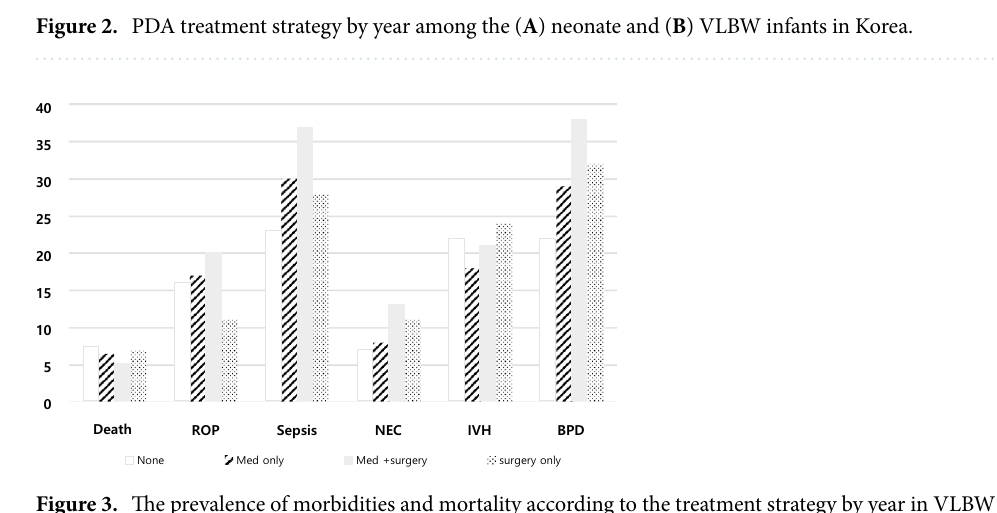
Figure 3. The prevalence of morbidities and mortality according to the treatment strategy by year in VLBW